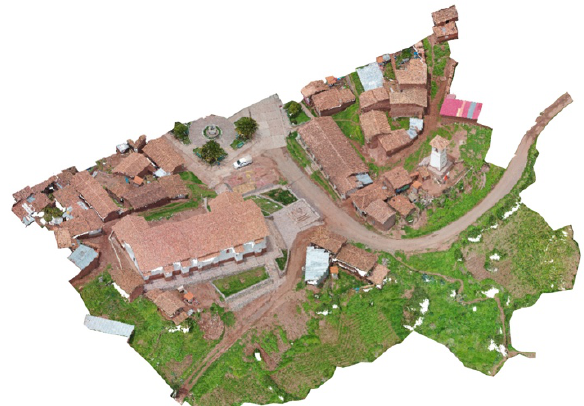
Figure 5 . Aerial photogrammetry of Kuñotambo. Image by CIMS © GCI 2019.